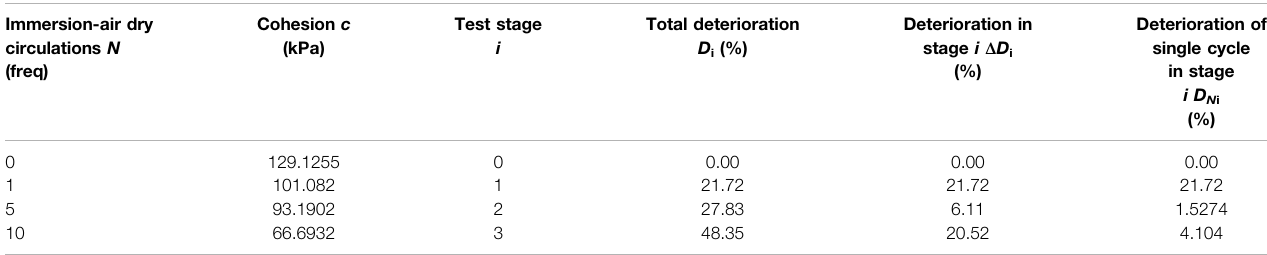
TABLE 5 | Cohesive deterioration analysis by I-AD circulations.